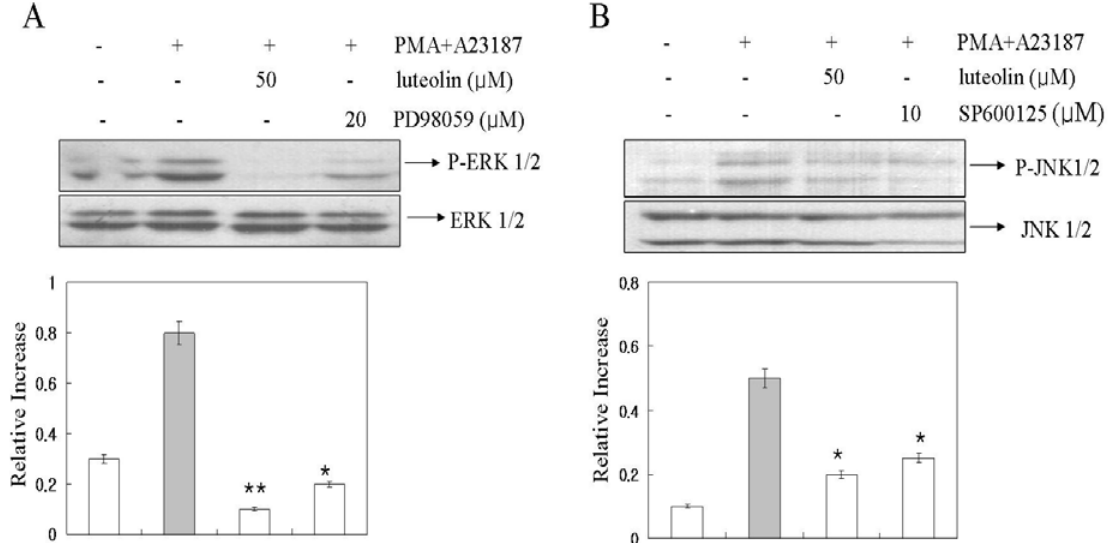
Figure 5. Effect of luteolin on activation of